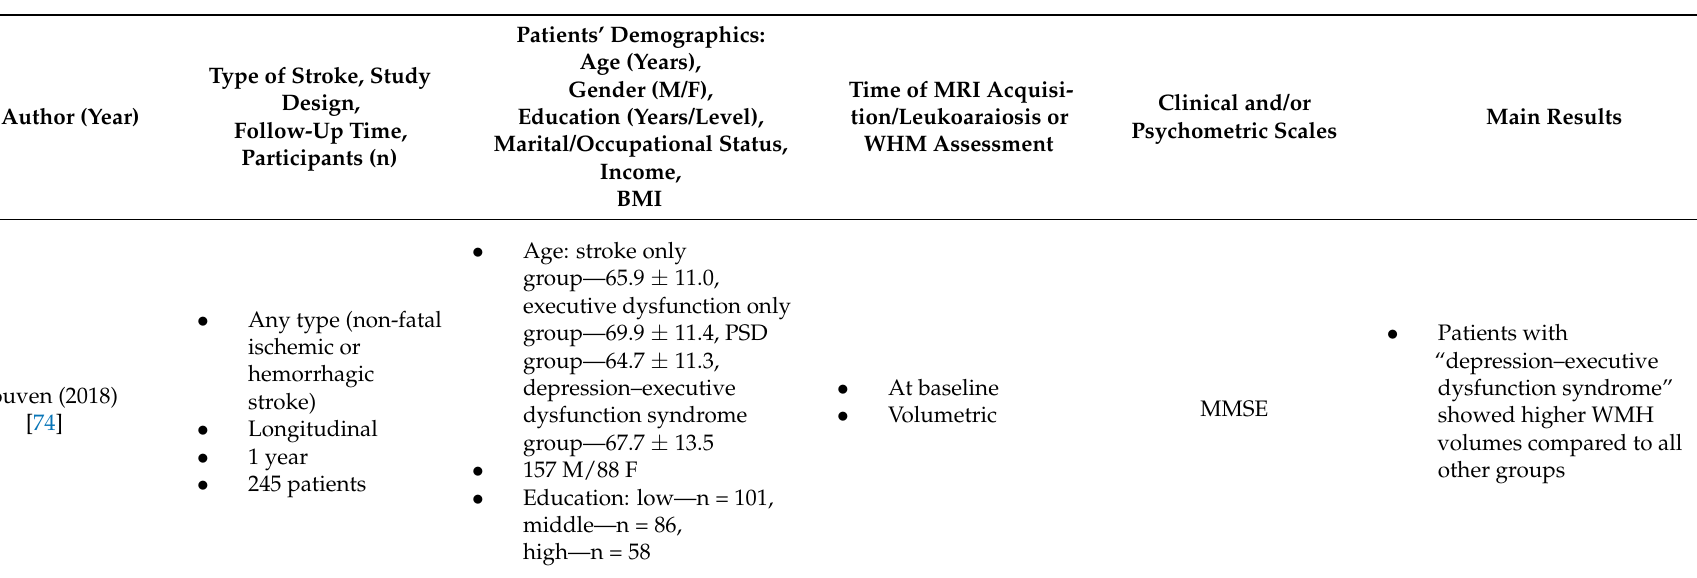
Table 4. Characteristics of included studies focusing on depression and